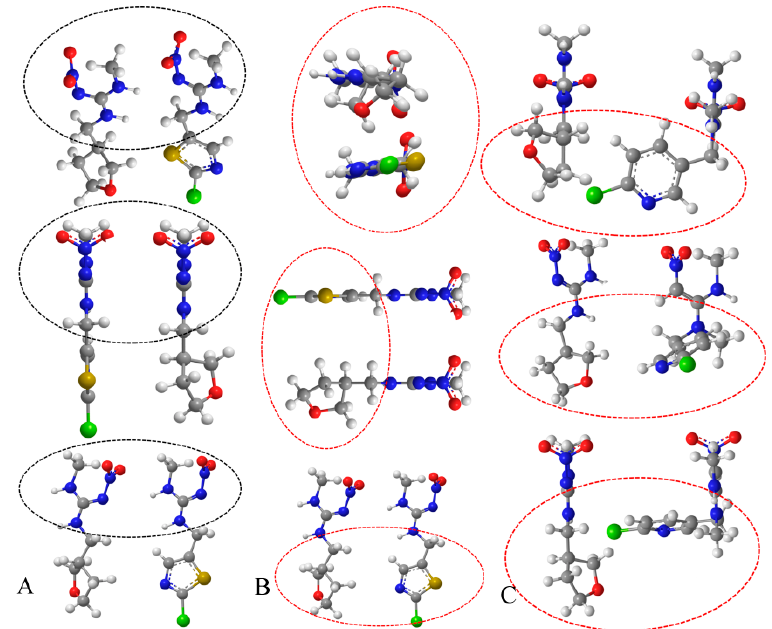
Figure 2. Spatial structures of analytes (The analyte with a green atom was clothianidin in column A and B , and correspondingly, it was nitenpyram in column C . The other molecular in each column is dinotefuran. The black and red circle in the figure manifested the same and di ff erent structure of the analytes,